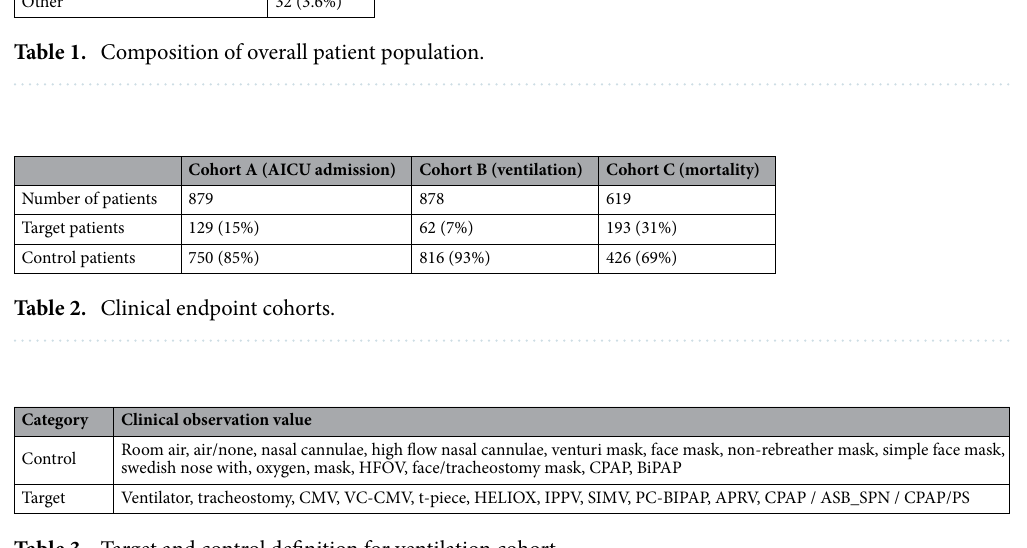
Table 3. Target and control definition for ventilation